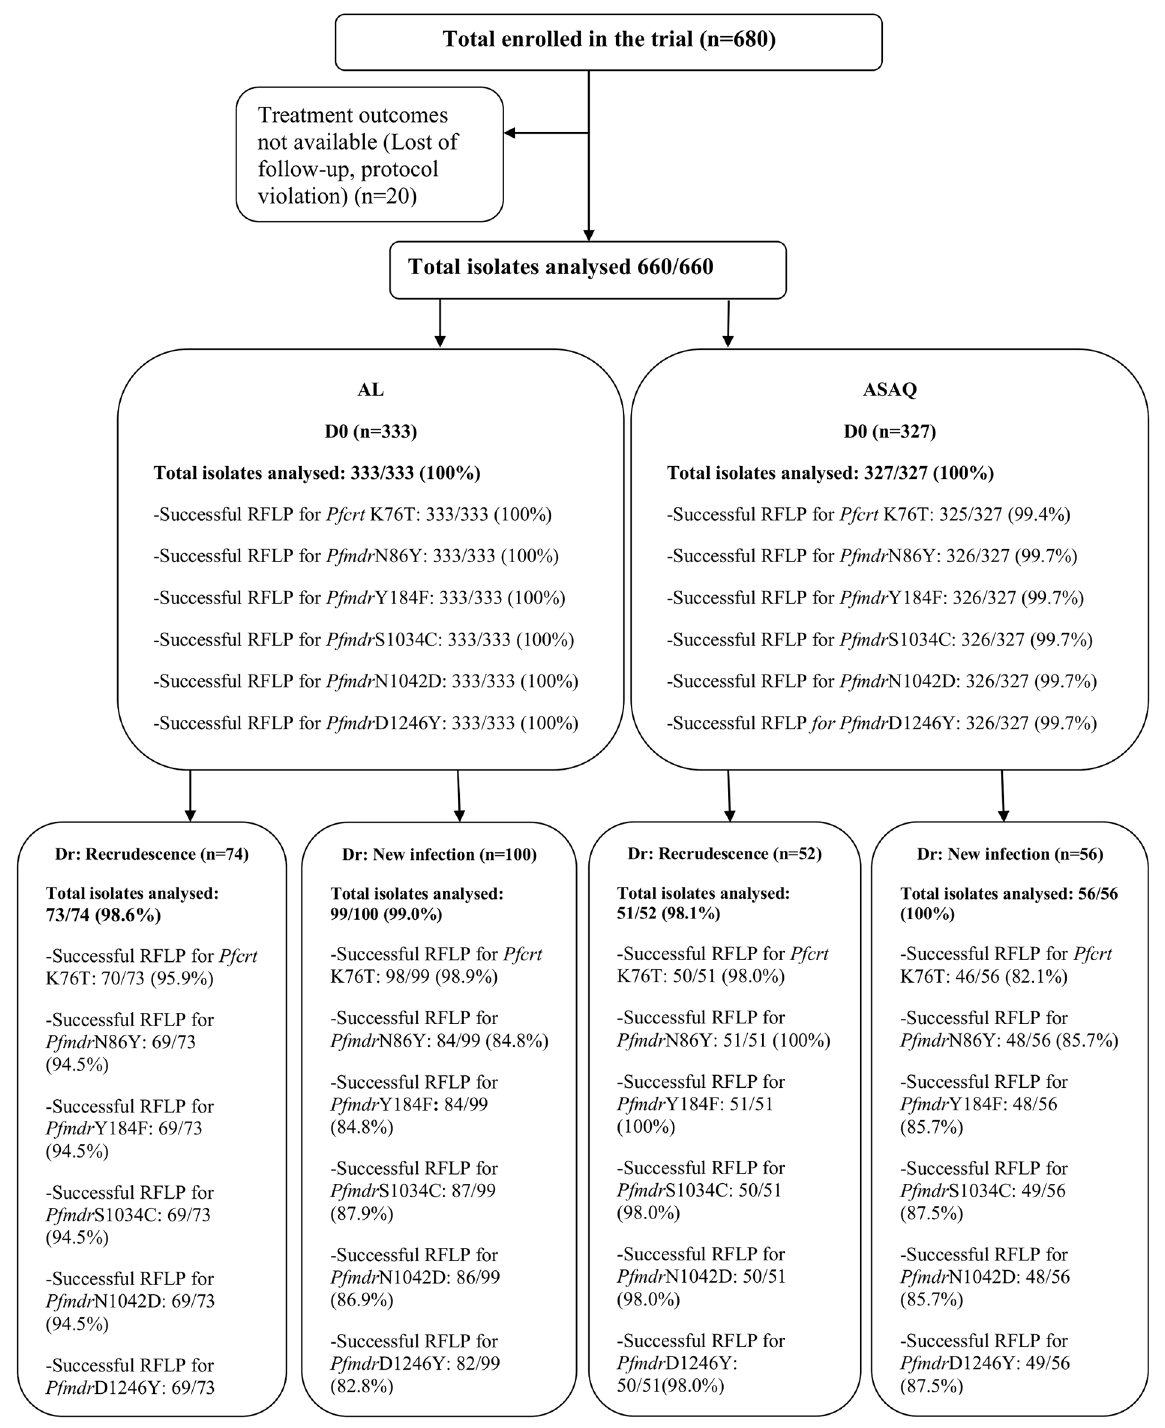
Fig 1. Trial profile. The figure shows the number of isolates analyzed at day 0 and on the Day of recurrent parasitaemia (recrudescence and new infections) by treatment group (AL and ASAQ) and the number of successful PCR-RFLP amplification.